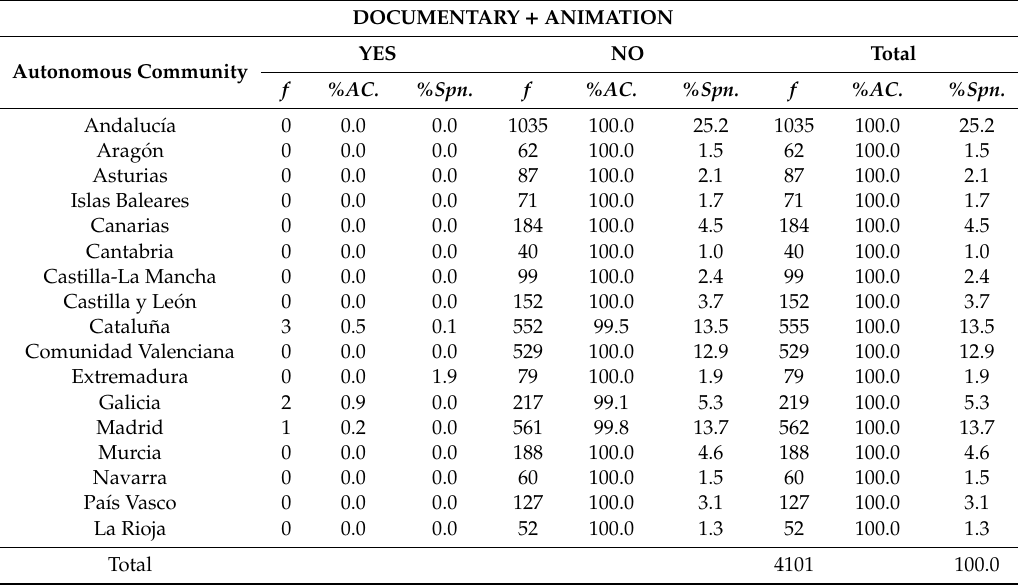
Table 9. Percentages and frequencies of documentary and animation films seen by teacher (cid:48) s degree students, according to the Autonomous Community.